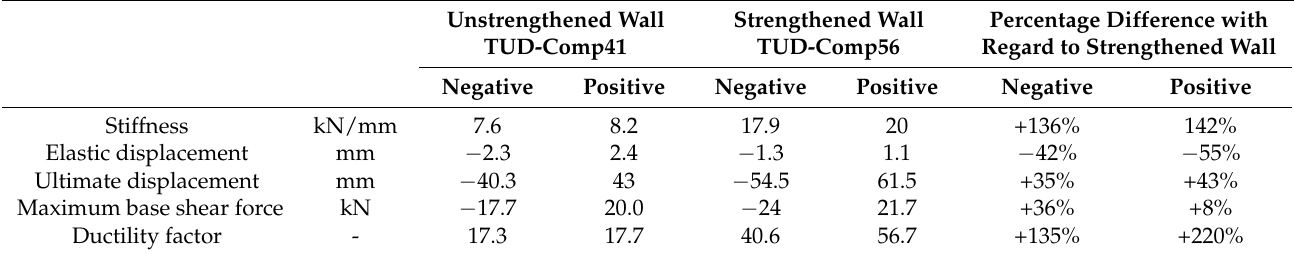
Figure 15. Performance during the ULS protocol: ( a ) equivalent bilinear curve and ( b ) contour plot. Table 2. Overview of the parameters of the bilinear curve.